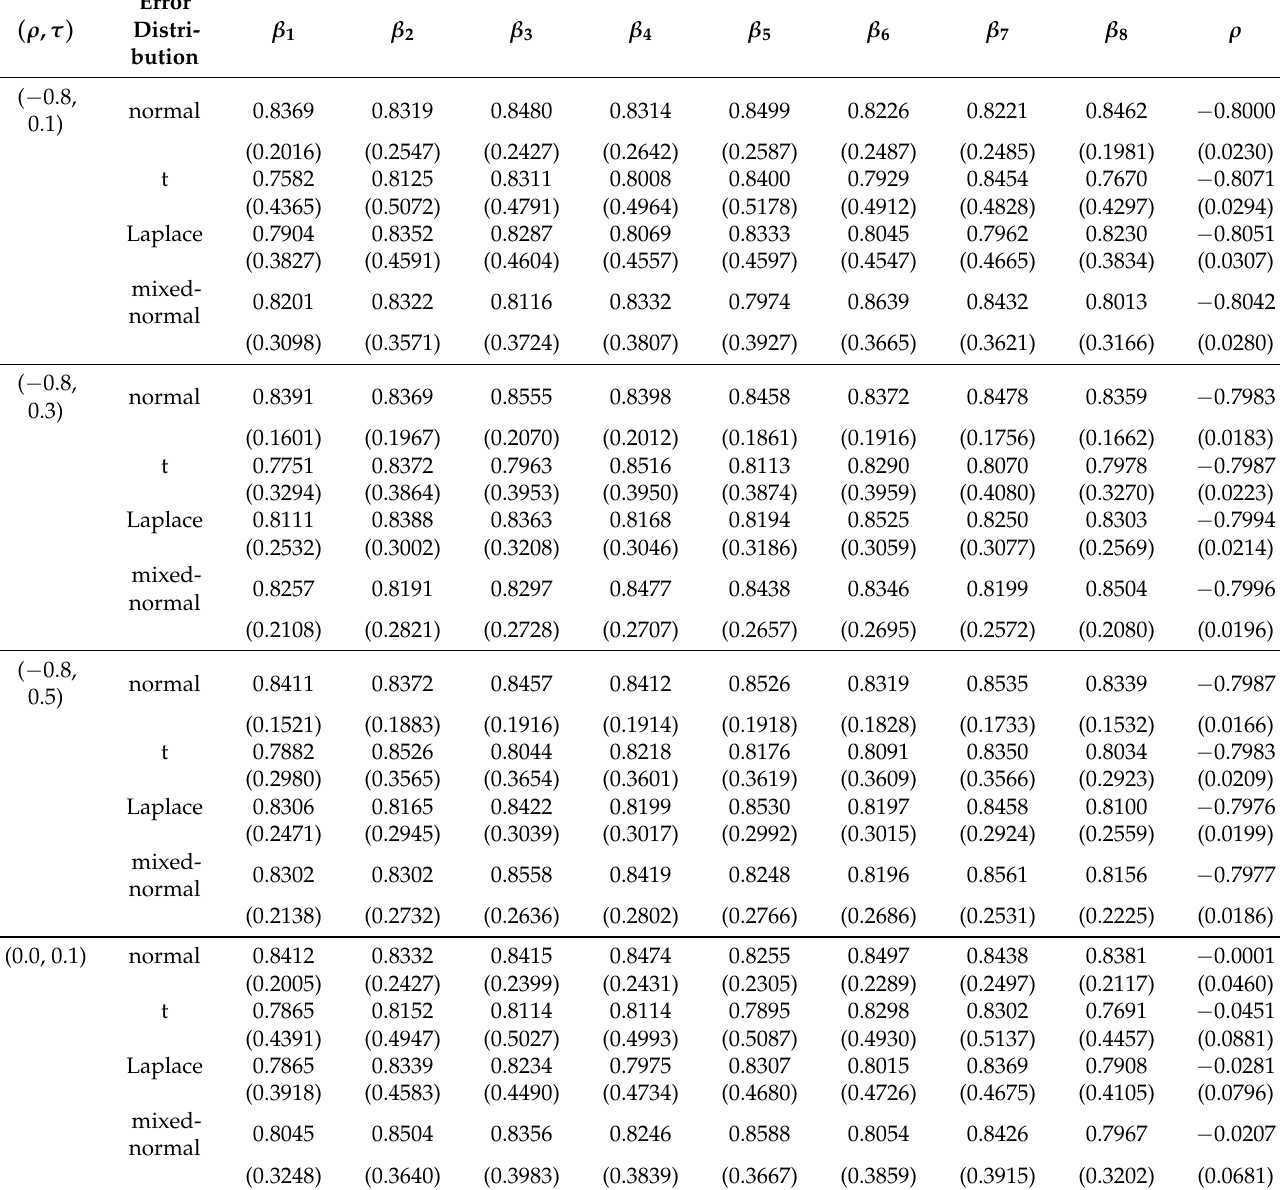
Table 1. Means and RMSEs (in parentheses) in the first simulation study under Scenario